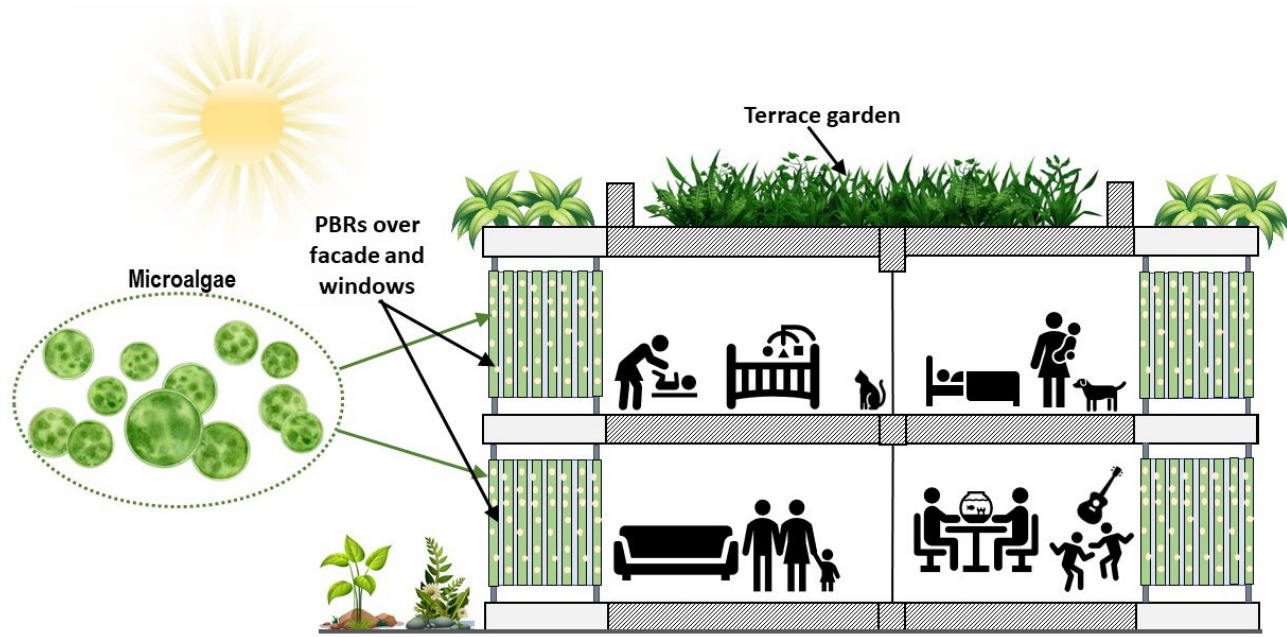
Figure 6. Example of integration of microalgae PBRs and plants in buildings (authors’ own creation).